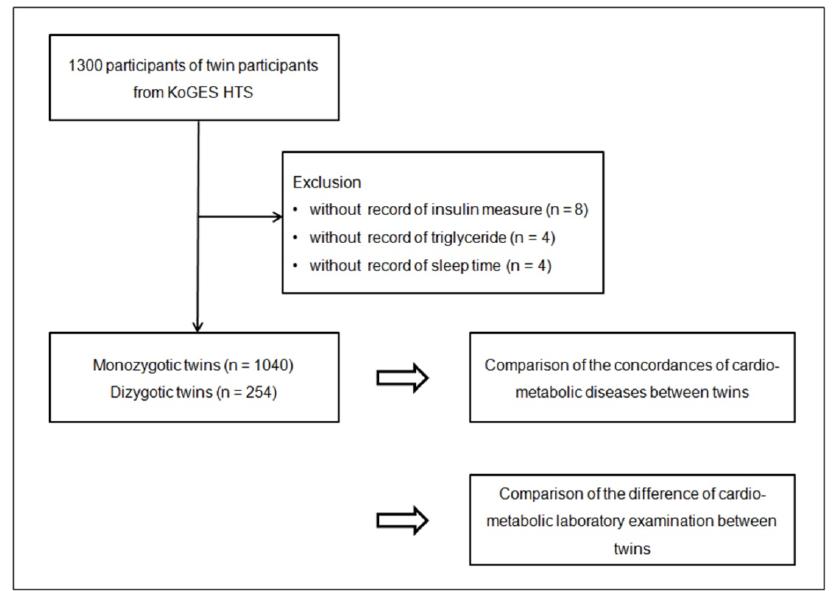
Figure 1. The study design of this study. The 1040 monozygotic twins and 254 dizygotic twins were compared for the concordance of various cardiometabolic diseases and the difference in physical and laboratory examination results between twins.